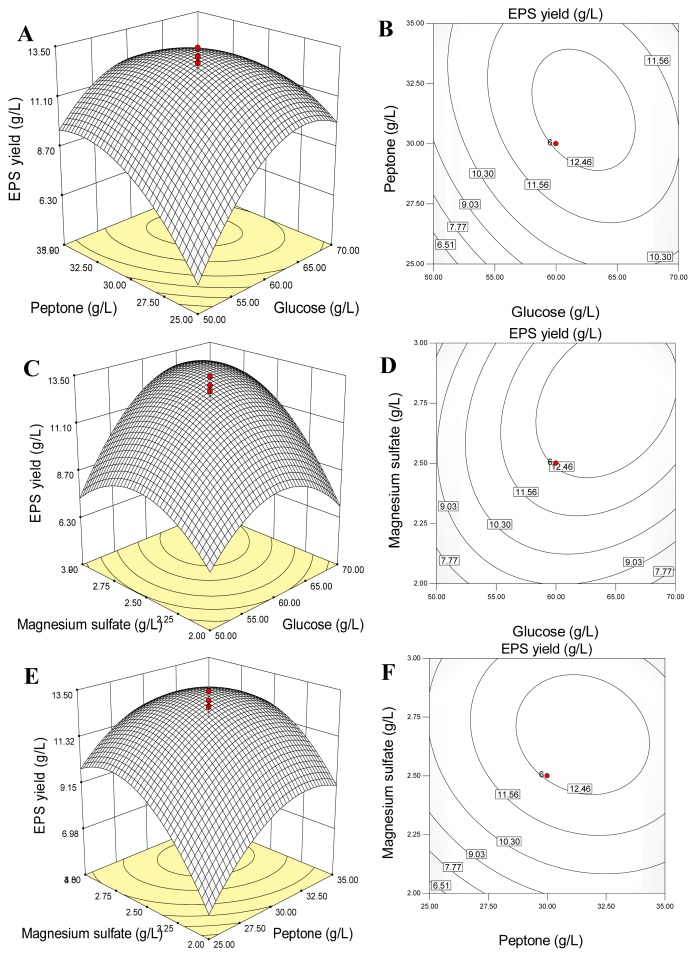
The 3D-response surface and 2D-contour plots of EPS yield (g/L) versus the tested variables (g/L): glucose and peptone (A,B); glucose and MgSO4·7H2O (C,D); peptone and MgSO4·7H2O (E,F).